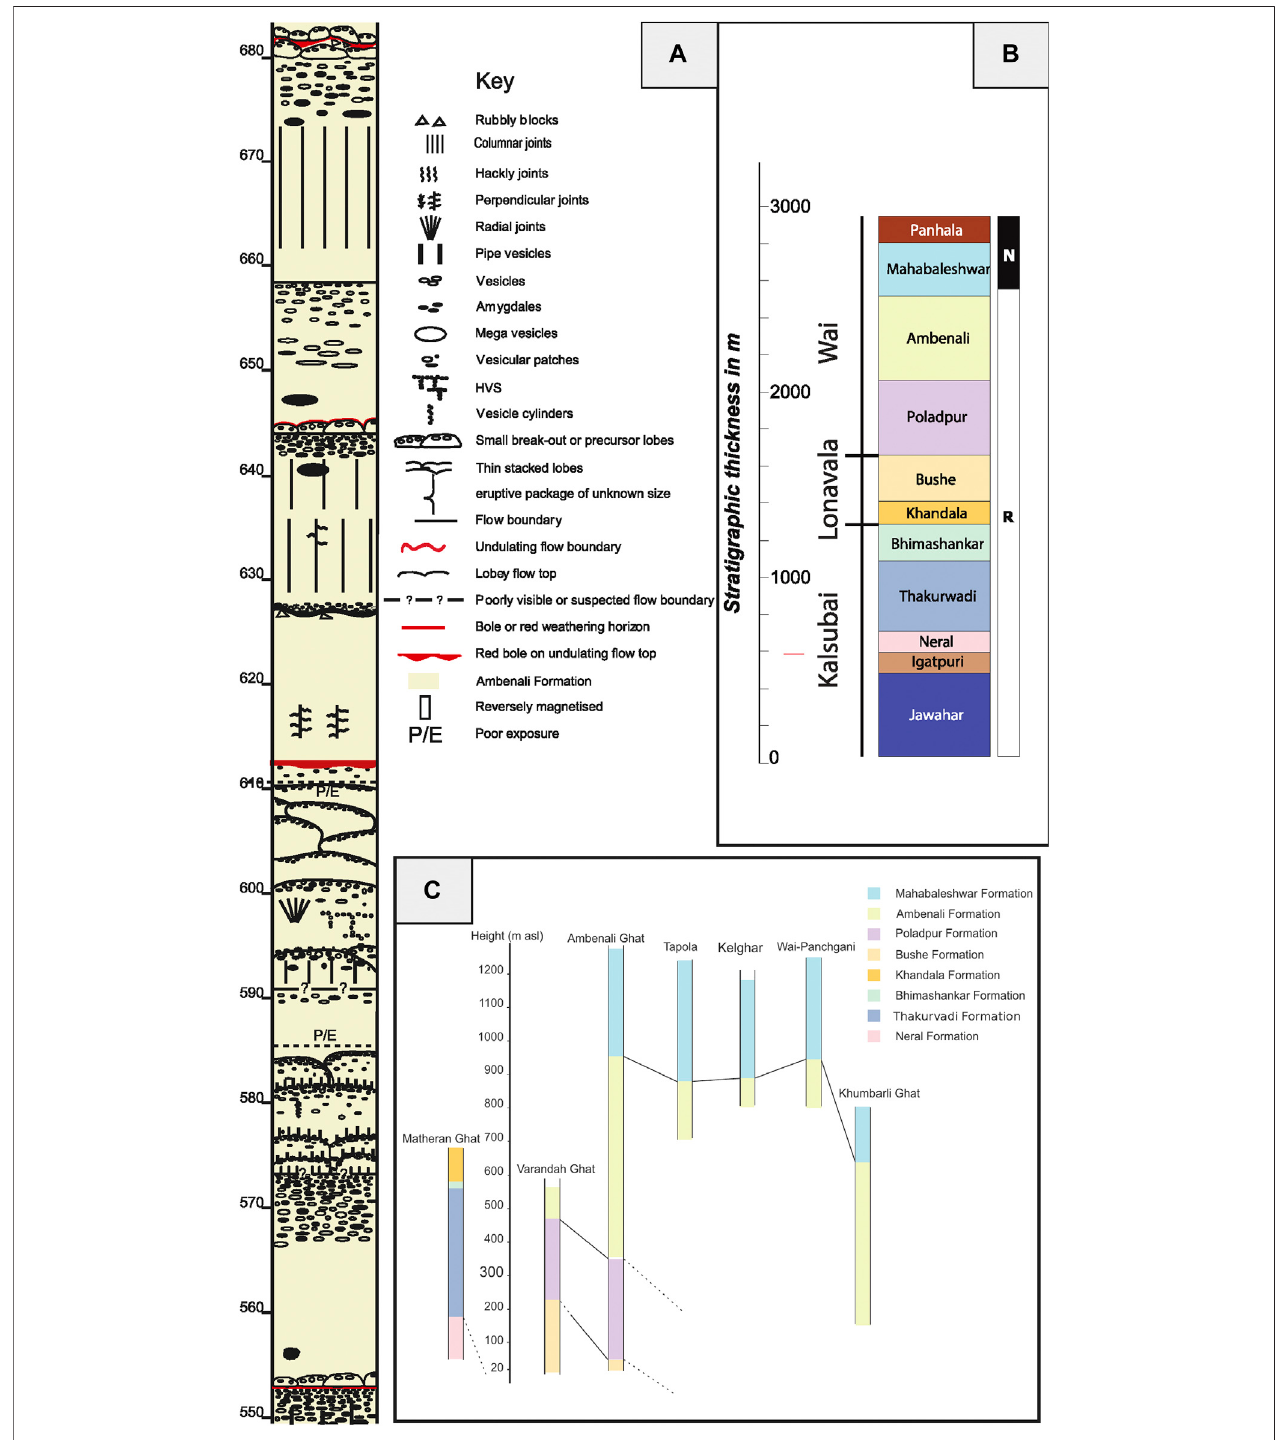
FIGURE 3 | (A) Detailed log of small section of Ambenali Ghat traverse, Deccan Volcanic Province, within Ambenali Formation lavas (see Figure 3B ) illustrating variety of morphologies in lava fl ows within one chemo-stratigraphic formation. Section is from 550 to 680 m above sea level and shows several sheet lobes under- and overlain by smaller precursor and break-out lobes, respectively, as well as other physical lava features indicated on key: from Jay (2005). (B) Composite section of Western Ghats lava fl ow stratigraphy showing geochemically de fi ned formations (following Beane et al., 1986). This study includes data from all named formations exceptJawar, Igatpuri,and Panhala.Magneticpolarityoflavasisexpressed atright,R – chron29r;N (cid:1) chron29n,afterJayetal.(2009). (C) Simpli fi edstratigraphiclogs of various Deccan transects showing geochemical formations (following Jay et al., 2009).